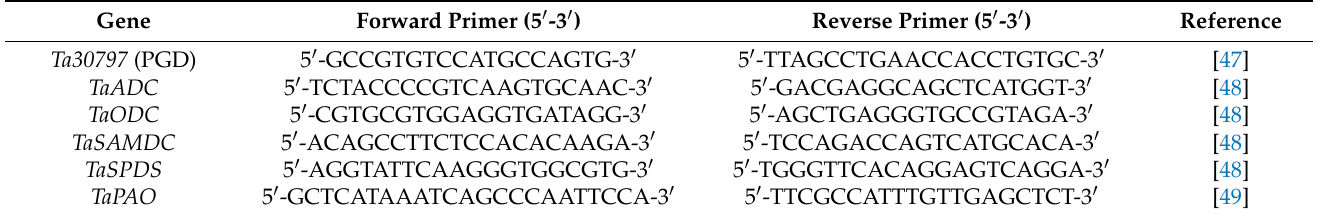
Table 2. Primers used for analysing the expression of genes involved in biosynthesis of polyamines in wheat by quantitative real time